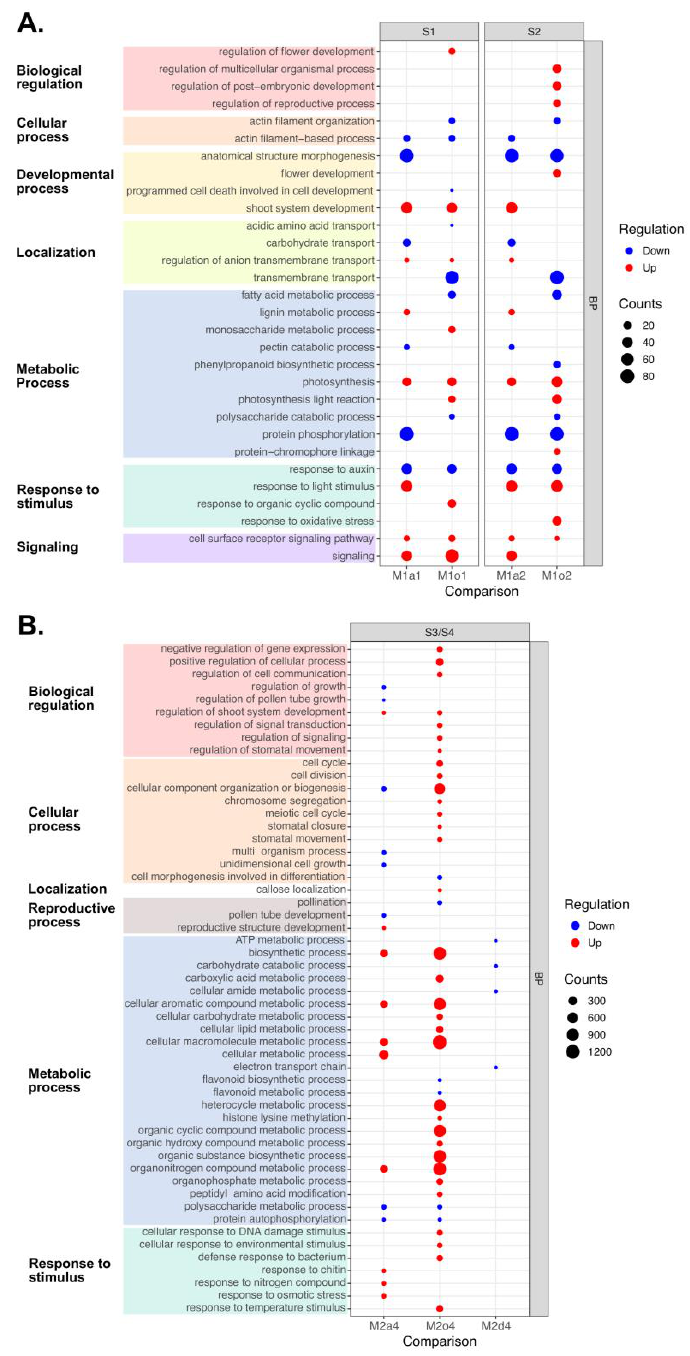
Figure 4. Over-representation analysis (ORA) performed by gProfiler of differentially expressed genes (DEGs) in ovules from apomictic L. multiflorum (M), sexual L. auriculifolium (a) and L. ovalifolium (o), and facultative apomictic L. dodartii . DEGs were filtered by |log2 fold-change (log2FC)| >2. A.s thaliana, the most similar homolog of each differentially expressed gene (DEG) was mapped to the respective functional annotation, and enriched terms were summarized using REVIGO. Significantly (FDR < 0.01), gene ontology (GO) and biological processes (BP) terms are among DEGs from ( A ) apomictic in S1 relative to sexual ovules in S1 (M1a1 and M1o1) or S2 (M1a2 and M1o2), and from ( B ) apomictic in S2 relative to sexual ovules in S3/S4 (M2a4 and M2o4), and facultative apomictic in S4 (M2d4). The dot’s size indicates the number of DEGs annotated with each term (counts), and the color shows the differential expression (red: up-regulated; blue: down-regulated). Enriched terms are grouped by their respective ancestors (ontology level